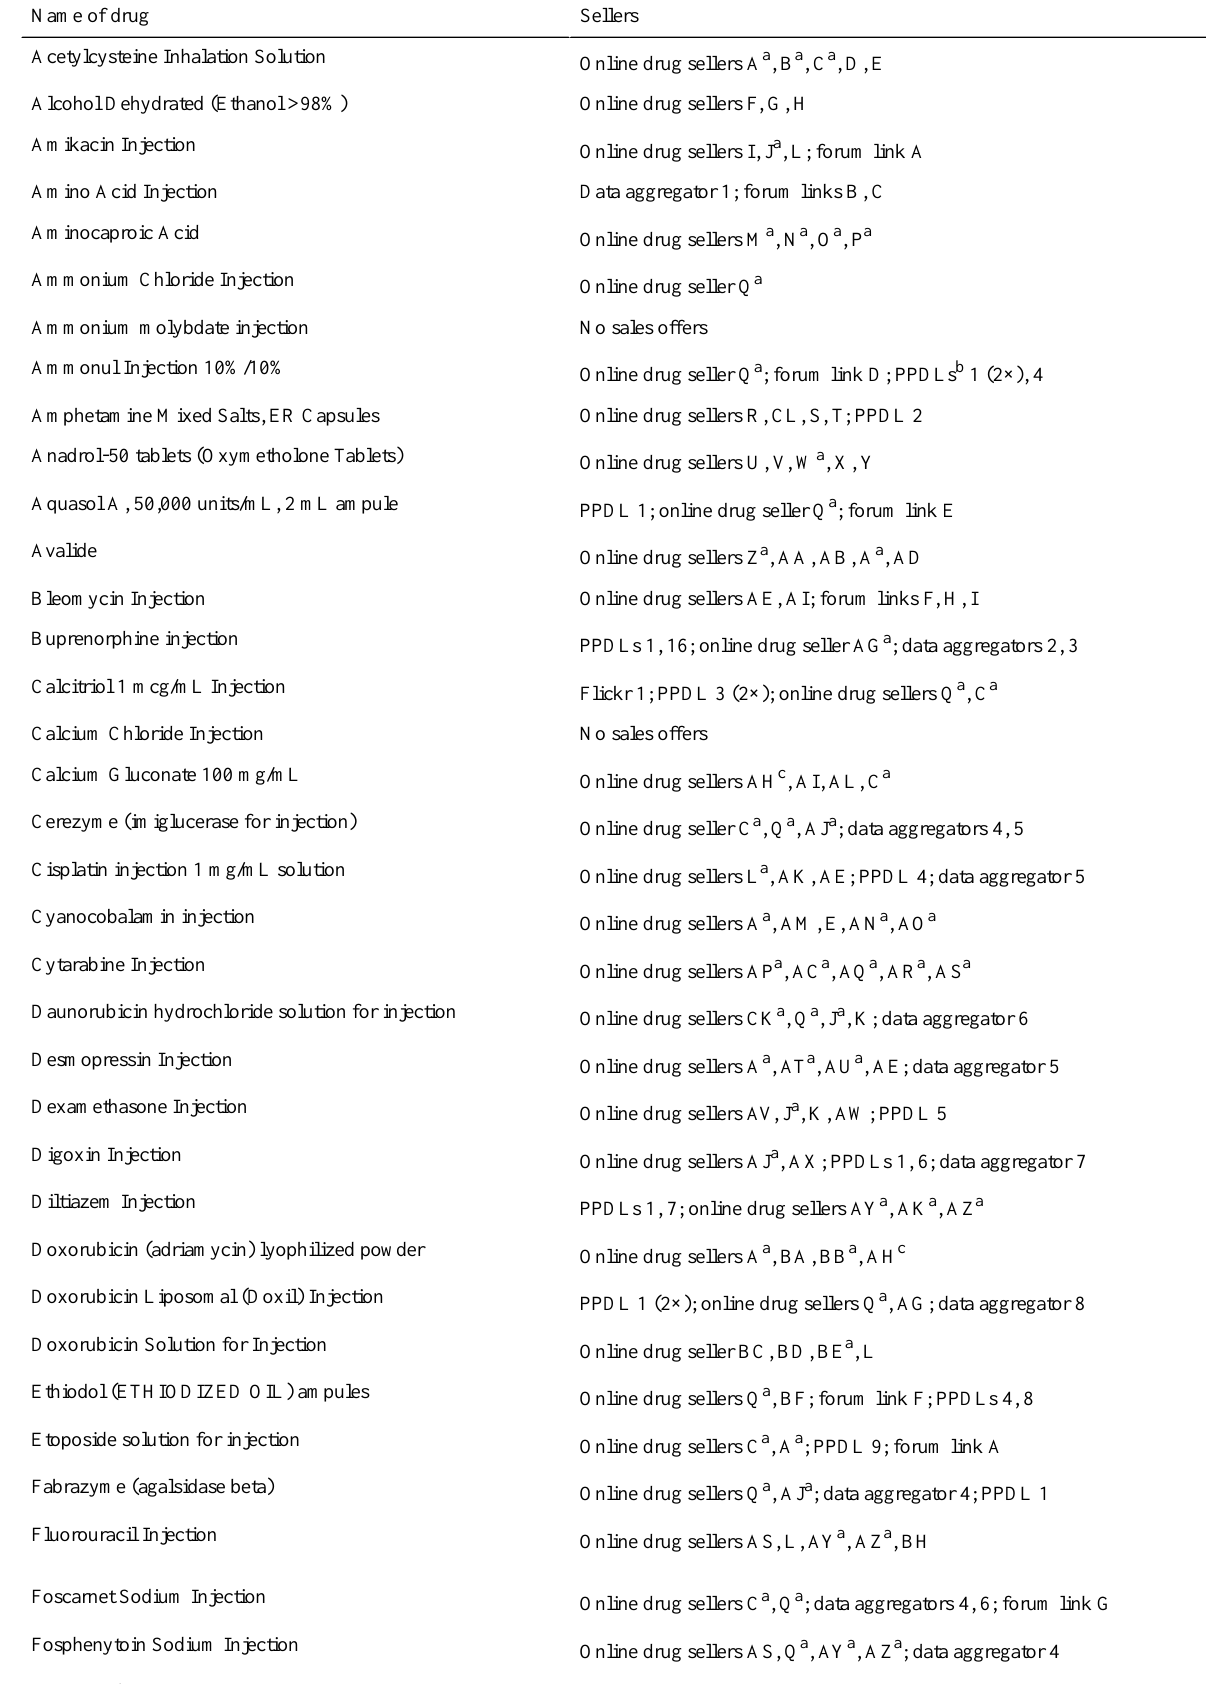
Table 1. US Food and Drug Administration Current Drug Shortages list and Internet sellers (September 23, 2011) SellersName of